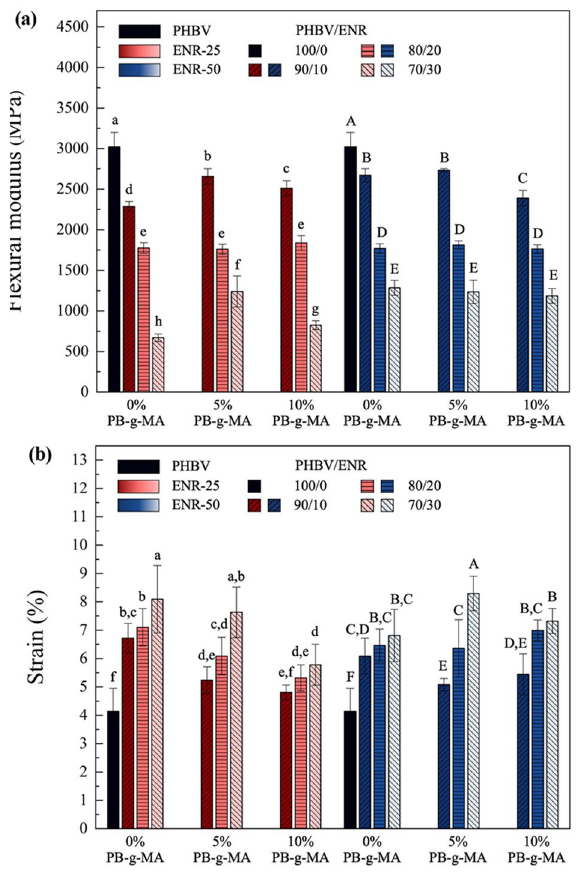
Figure 6. The flexural properties of PHBV/ENR blends ( a ) Flexural modulus and ( b ) Strain at break. Data are presented as mean ± SD. Groups designated with different letters are significantly different using One-Way ANOVA with Duncan’s multiple range post hoc (at p < 0.05, n =